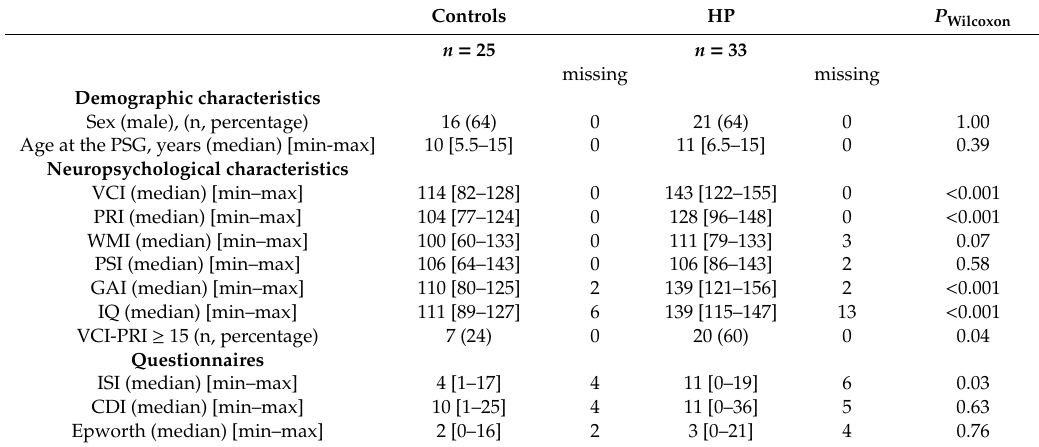
Table 1. Demographic, questionnaires and neuropsychological characteristics for children with HP and controls.